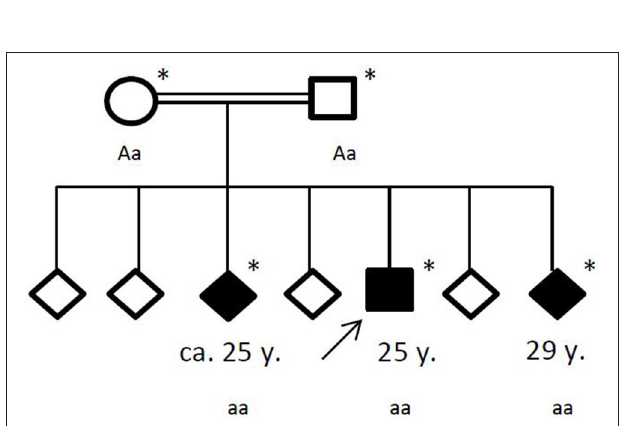
FIGURE 4 | Pedigree of the affected family, with age of first epileptic seizure in years (y). Arrow: index patent. Asterisk: genetic testing performed. Aa, heterozygous; aa, homozygous for c.4326 T > A (p.Tyr1442*).